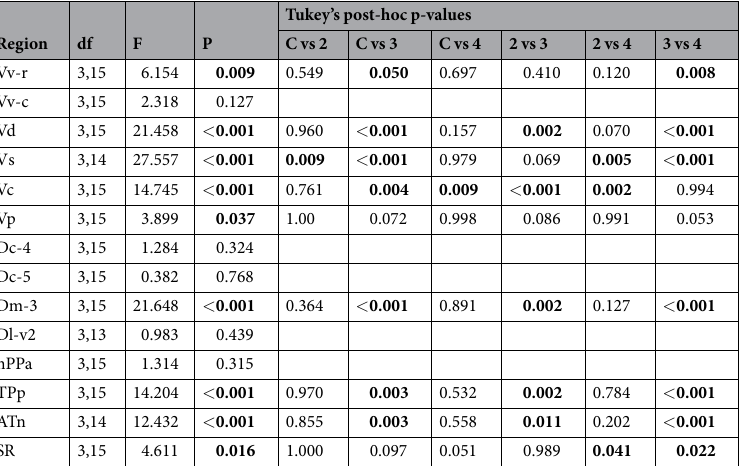
Table 1. Effect of coping behaviours on neural activation measured via pS6-stained cell density. Bold indicates statistical significance at P < 0.05. C: control; 2, 3, and 4: fish collected on days 2, 3, or 4 of repeated acute social defeat. See text for abbreviations of brain